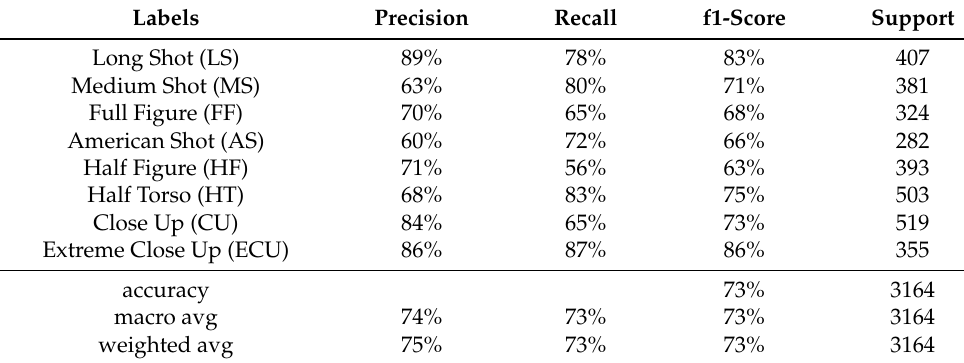
Table 20. Precision recall and f1-score of the Cerberus model trained on the three datasets.